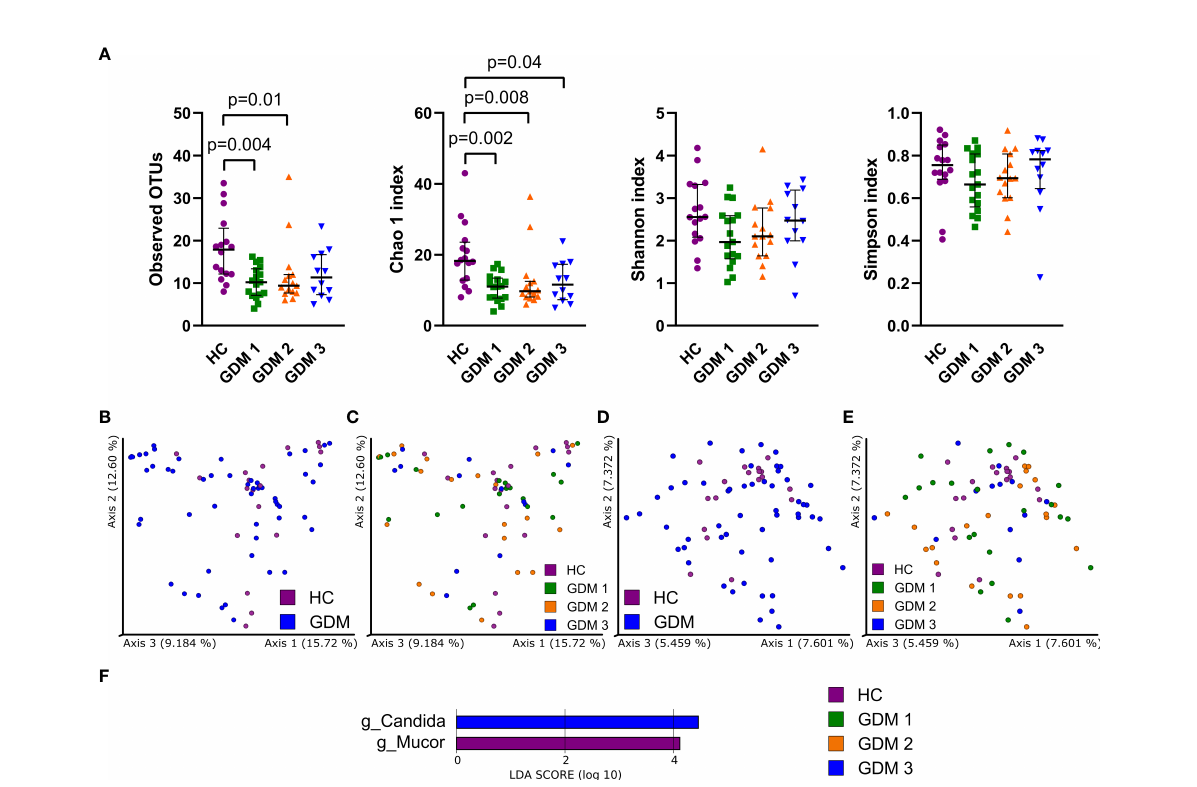
FIGURE 2 Gut fungal microbiota composition in the fi rst trimester of pregnancy. (A) Alpha diversity indexes. Beta diversity of gut fungi on Bray-Curtis (B, C) and Jaccard (D, E) distance metric-based PCoA graphs show comparison of control healthy pregnancies (HC) with those with gestational diabetes mellitus (GDM) diagnosed at any time during the pregnancy. (F) LEfSe analysis of signi fi cantly different strains among groups. Statistically signi fi cant differences were measured by Kruskal-Wallis test with Dunn´s post-hoc testing. The data are presented as medians with interquartile range. OTUs,ndash; operational taxonomic